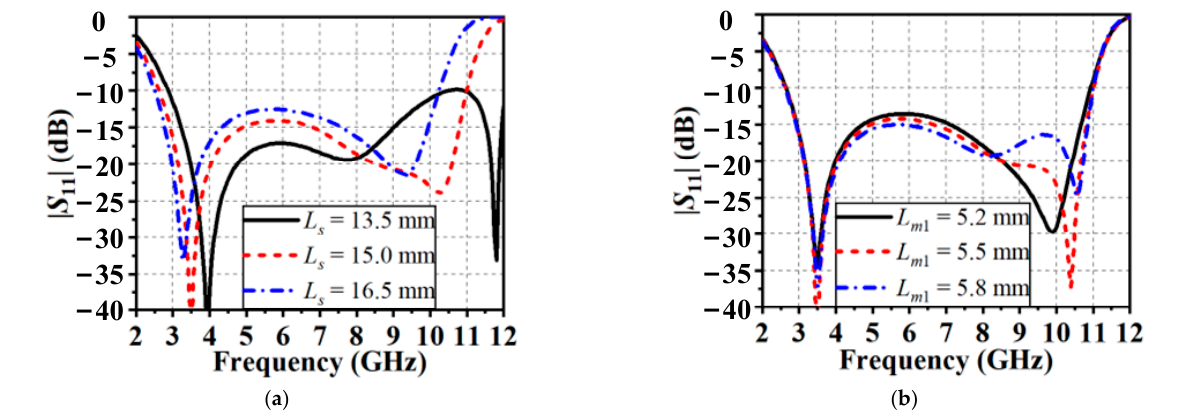
Figure 3. Simulated | S 11 | of the proposed absorber with different structure parameters: ( a ) L s and ( b ) L m 1 .